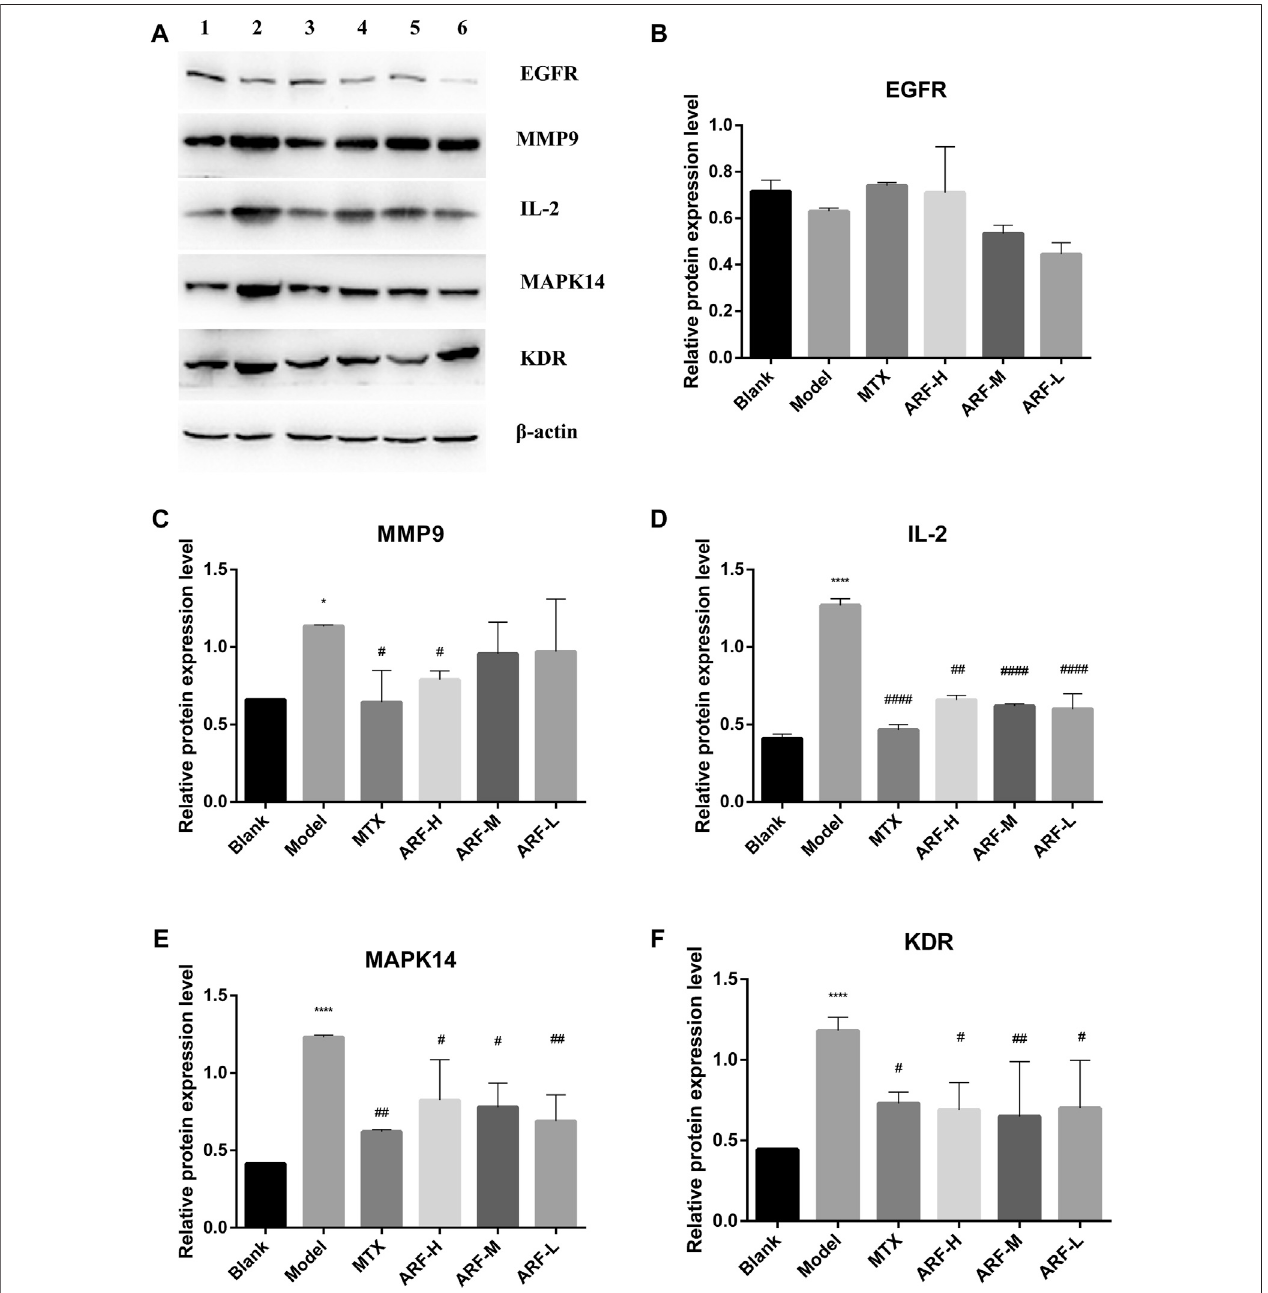
FIGURE9| ConsequencesofARFonthe fi vekeytargetproteinsproductionofIL-1 β – inducedHFLS-RA. (A) ExpressionsofEGFR,MMP9,IL2,MAPK14,andKDR proteindetectedbyWesternblot(1,Blankgroup;2,Modelgroup;3,MTXgroup;4,ARF-Hgroup;5,ARF-Mgroup;6,ARF-Lgroup). (B) EffectofARFontheexpression ofEGFR. (C) EffectofARFontheexpressionofMMP9. (D) EffectofARFontheexpressionofIL2. (E) EffectofARFontheexpressionofMAPK14. (F) EffectofARFonthe expression of KDR. * p < 0.05 and **** p < 0.001 stand for notable differences in comparison to the control group (Blank group); # p < 0.05, ## p < 0.01, or #### p < 0.001 con fi rm a striking difference compared with the IL-1 β – stimulated group (Model group).